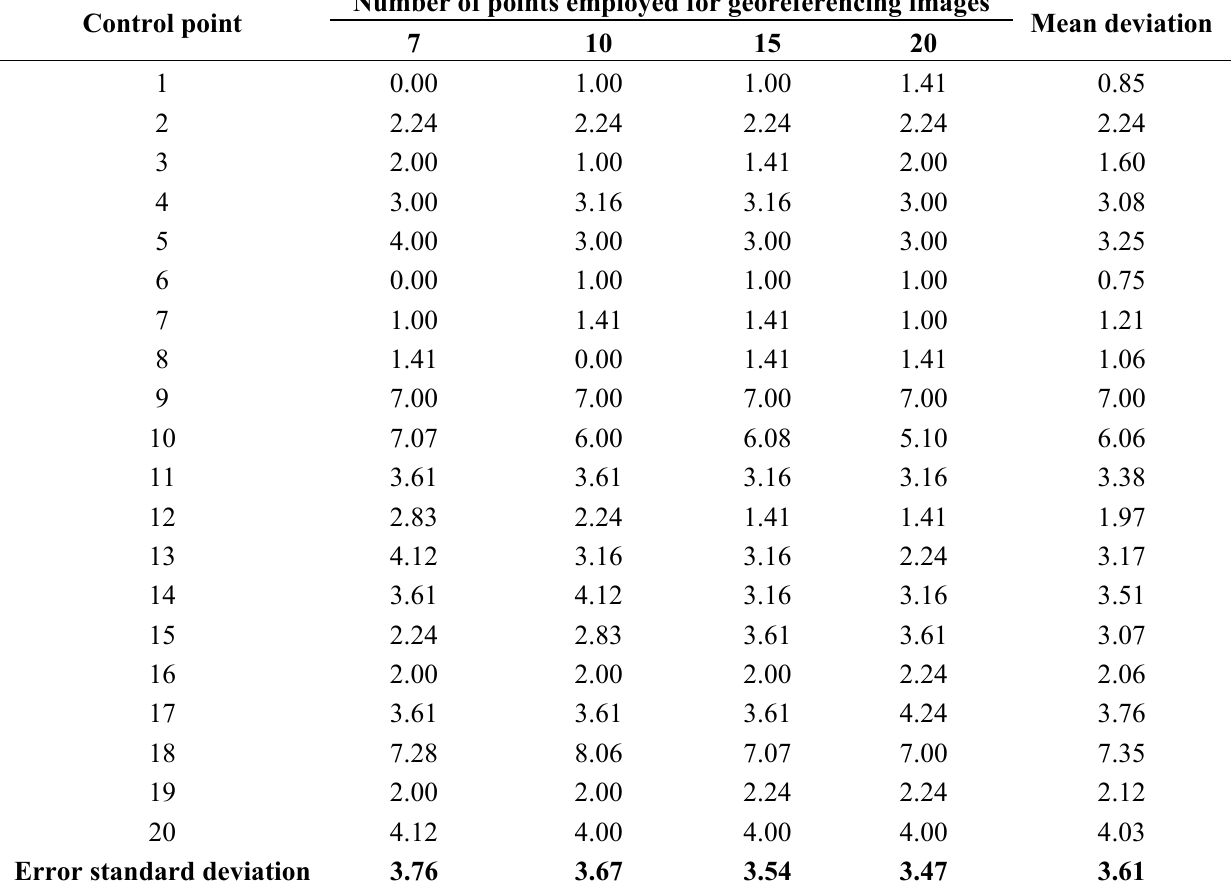
Table 1. Deviation (in pixels) between points in the reference map and in the map resulting from the georeferencing